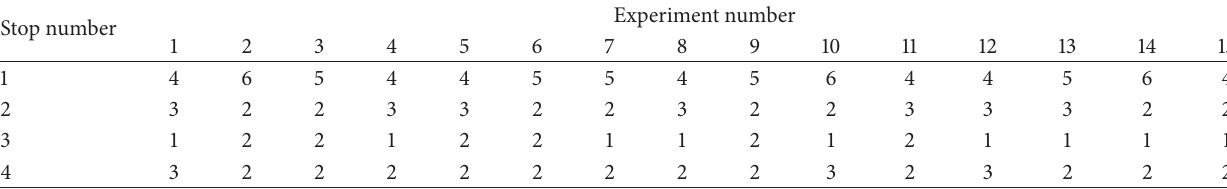
Table 3: Information on the number of incoming passengers.